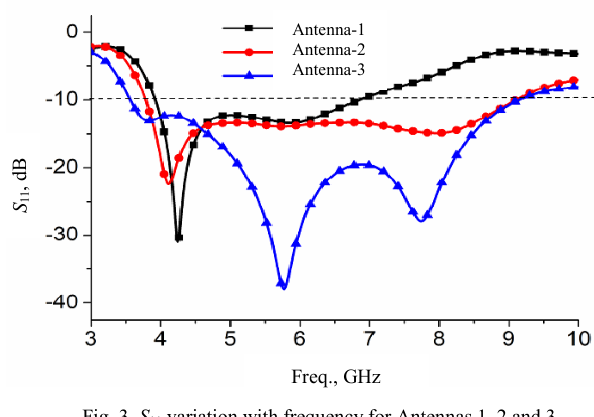
Fig. 3. S 11 variation with frequency for Antennas 1, 2 and 3.